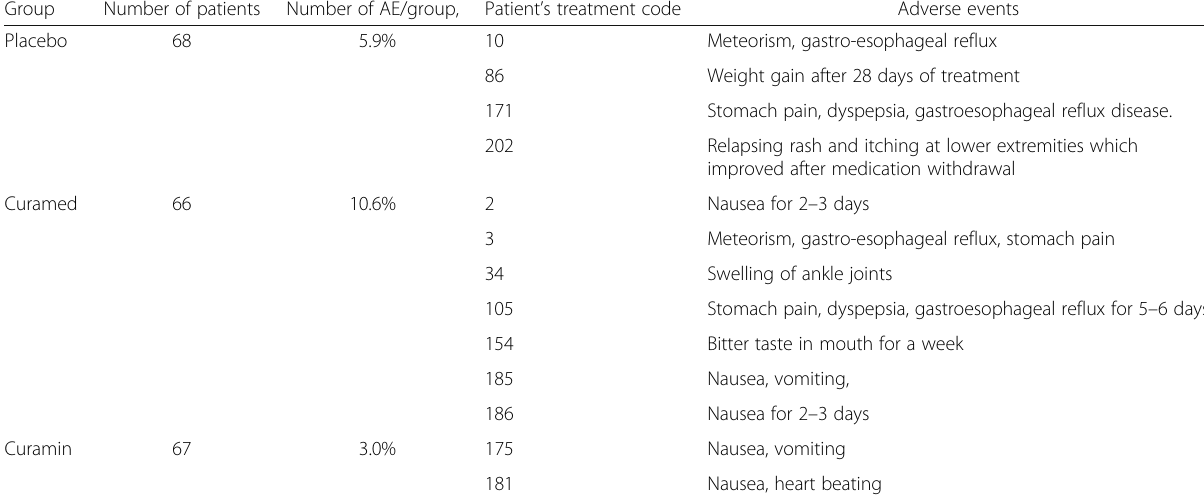
Table 7 Adverse events: treatment emergent signs and symptoms (TESS) - those not seen at baseline. Number observed and rate with patient identification Group Number of